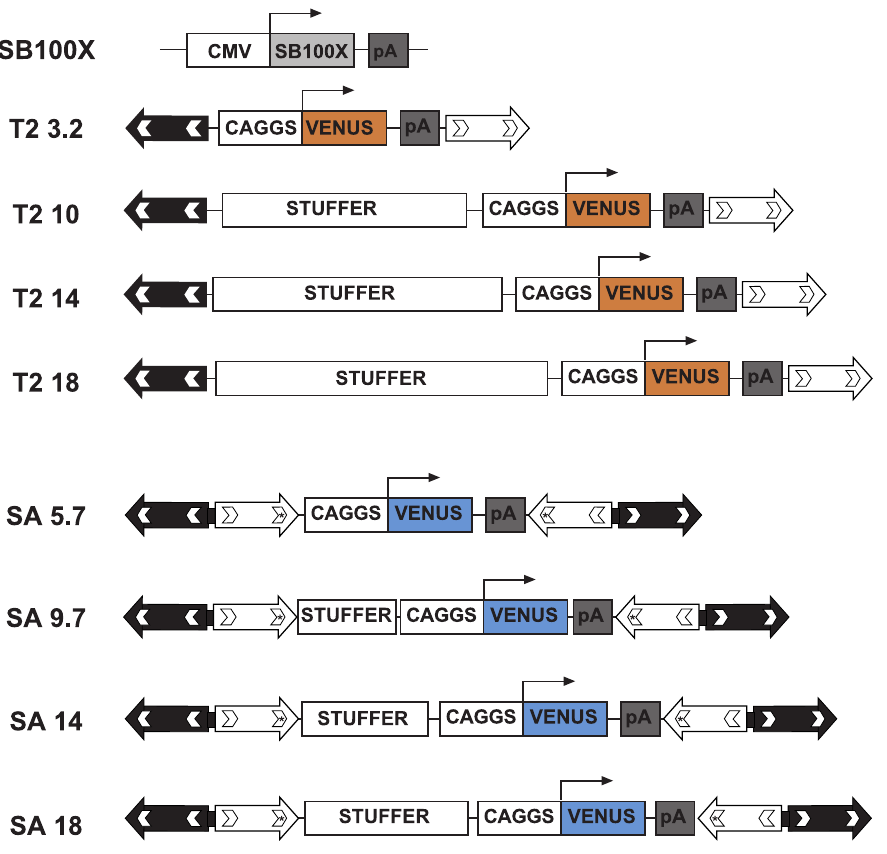
Figure 1. Transposon fleet. Schematic representation of the generated plasmids. SB100X carries the Hyperactive Sleeping Beauty transposase coding sequence placed under the control of the CMV promoter and followed by an SV40 poly-Adenylation (pA) signal. The transposons T2 and SA possess the expression cassette consisting of the CAGGS promoter, VENUS reporter gene and SV40 pA signal. The stuffer DNA represented has variable increasing size. The arrows represent the IR/DR ends recognised by the transposase. SA constructs are characterized by the presence of two complete IR/DR at each ends (white and black arrows) and the asterisks underline the IR mutated site not recognized as a catalytic substrate by the transposase. Numbers following T2 or SA abbreviation indicate the size in kilobases of the transposed cassette.